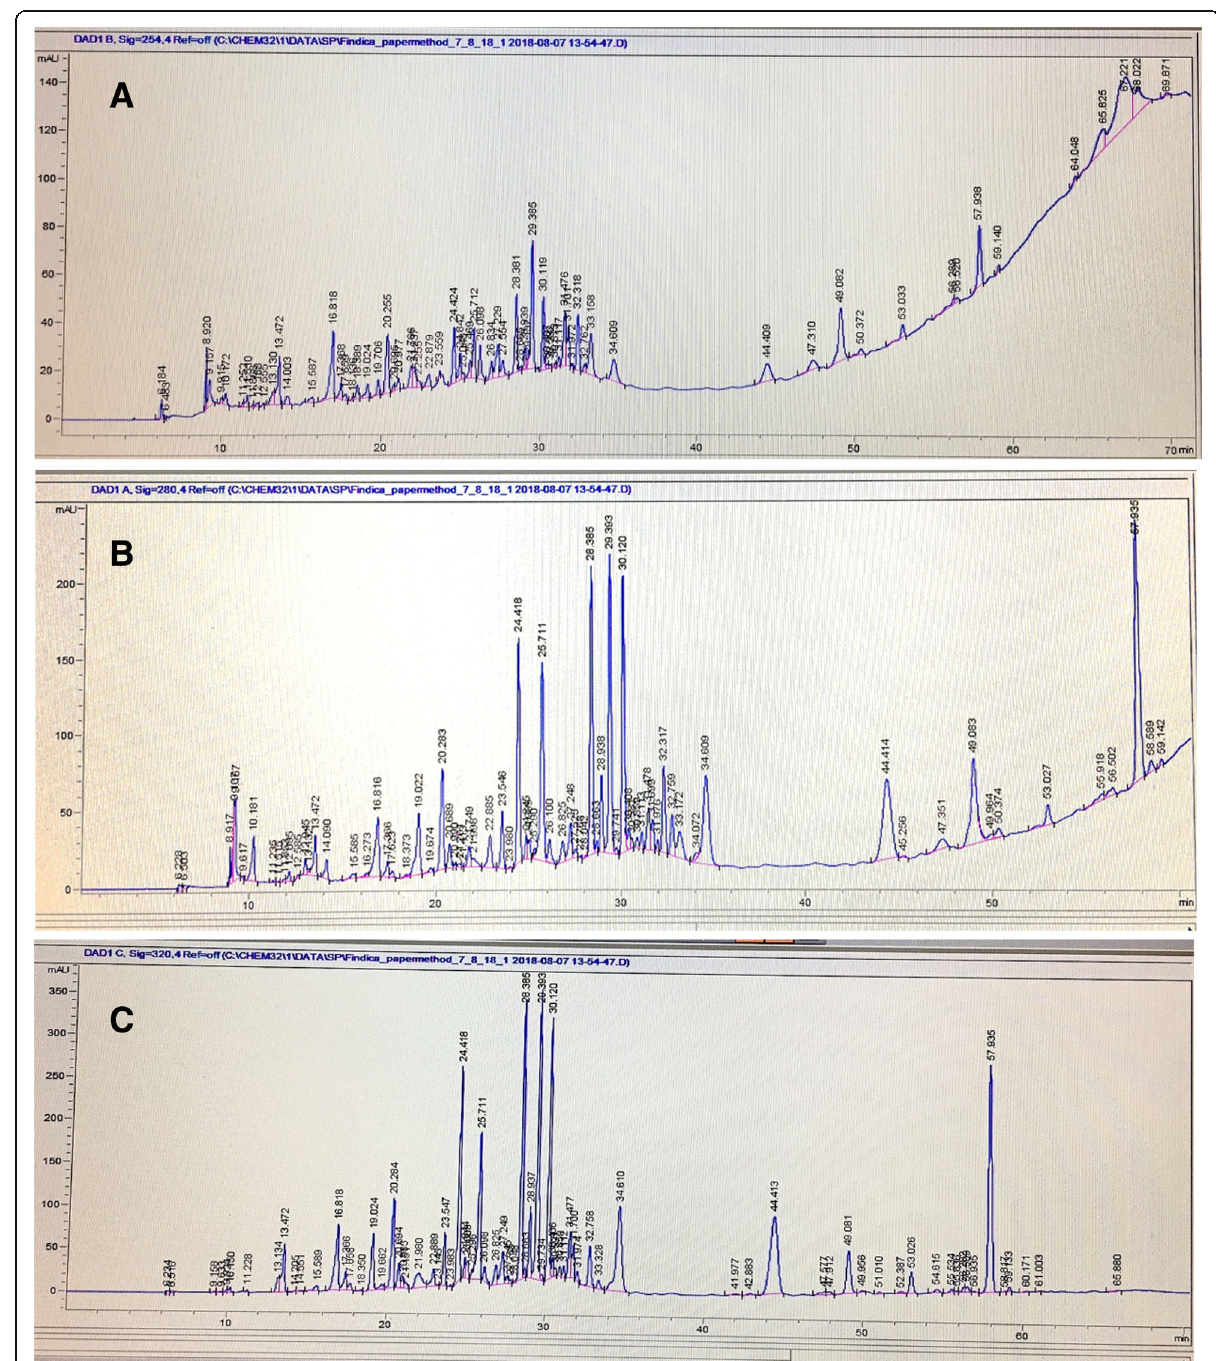
Fig. 6 HPLC chromatogram of ethanol bark extract of Flacourtia